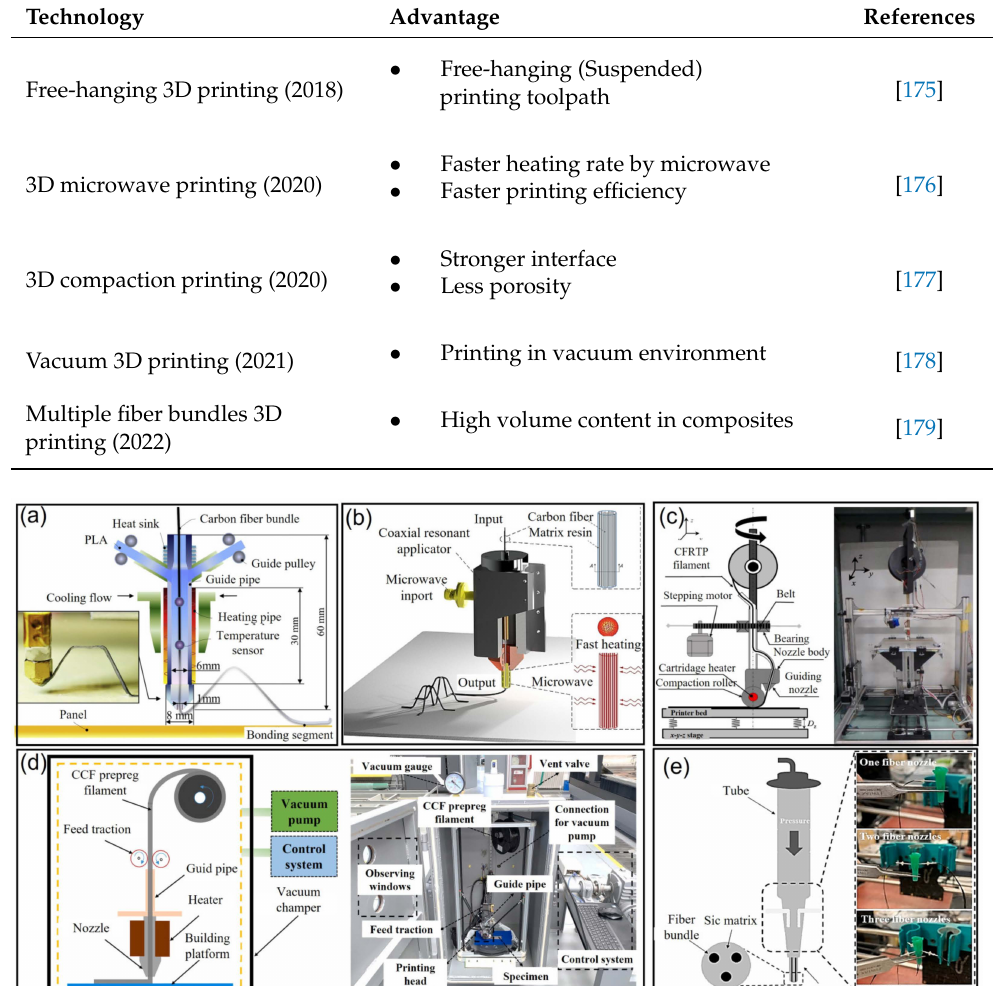
Figure 13. Traditional additive manufacturing technologies for continuous carbon fiber-reinforced composites. The diagrams of ( a ) free-hanging 3D printing (Reprinted with permission from Ref. [175]. 2018, Elsevier), ( b ) 3D microwave printing [176]. 2020, Elsevier), ( c ) 3D compaction printing [177]. 2020, Elsevier), ( d ) vacuum 3D printing (Reprinted with permission from Ref. [178]. 2021, Elsevier), and ( e ) multiple fiber bundles 3D printing (Reprinted with permission from Ref. [179]. 2022,